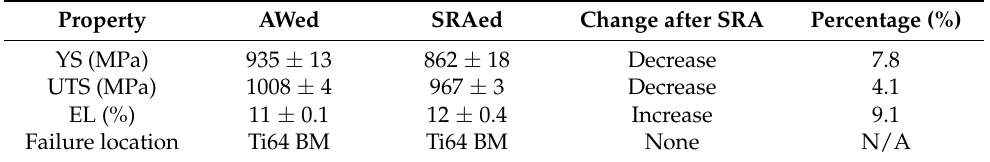
Table 3. Effect of SRA on the average mechanical properties of the dissimilar Ti6242–Ti64